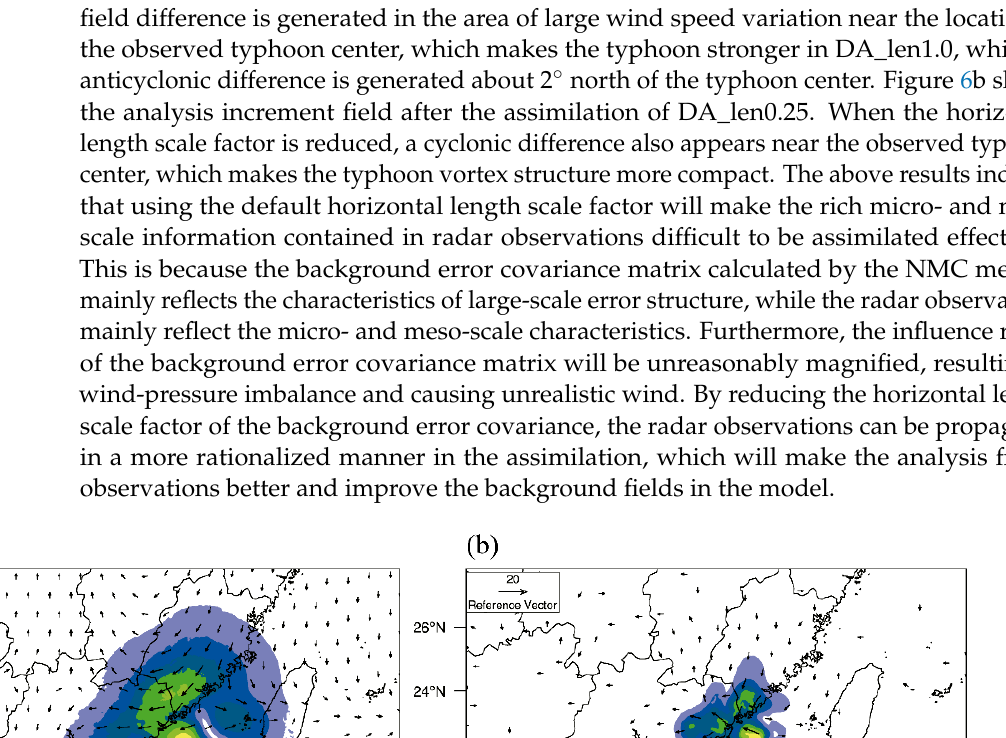
8 of 15 Figure 5. 700 hPa wind speed (shaded, unit: m s − 1 ) and wind vector (arrow, reference vector = 20 m s − 1 ) of the ( a ) CTRL, ( b ) DA_len1.0 and ( c ) DA_len0.25 experiments at 1800 UTC on 8 July 2015. In order to visually display the improvement of the radial wind assimilation, Figure 6 shows the analysis increments of 700 hPa wind fields at the first moment of assimilation